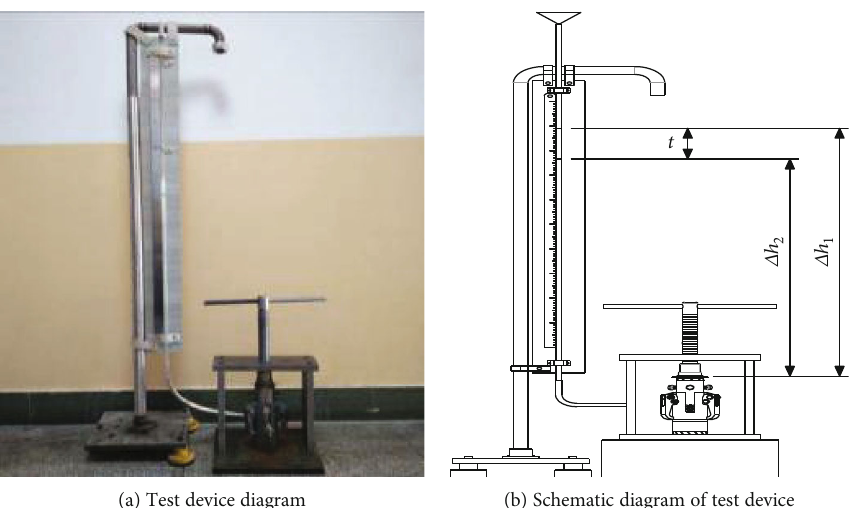
Figure 6: Test and test principle of permeability coe ffi cient of similar materials.